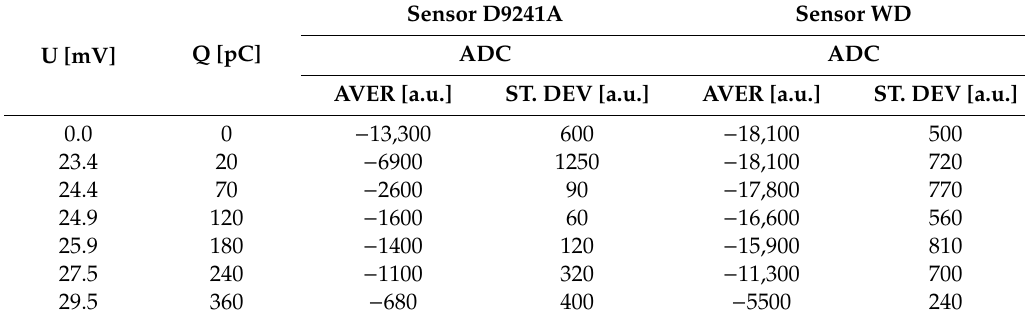
Table 1. The results of calibration of measuring system